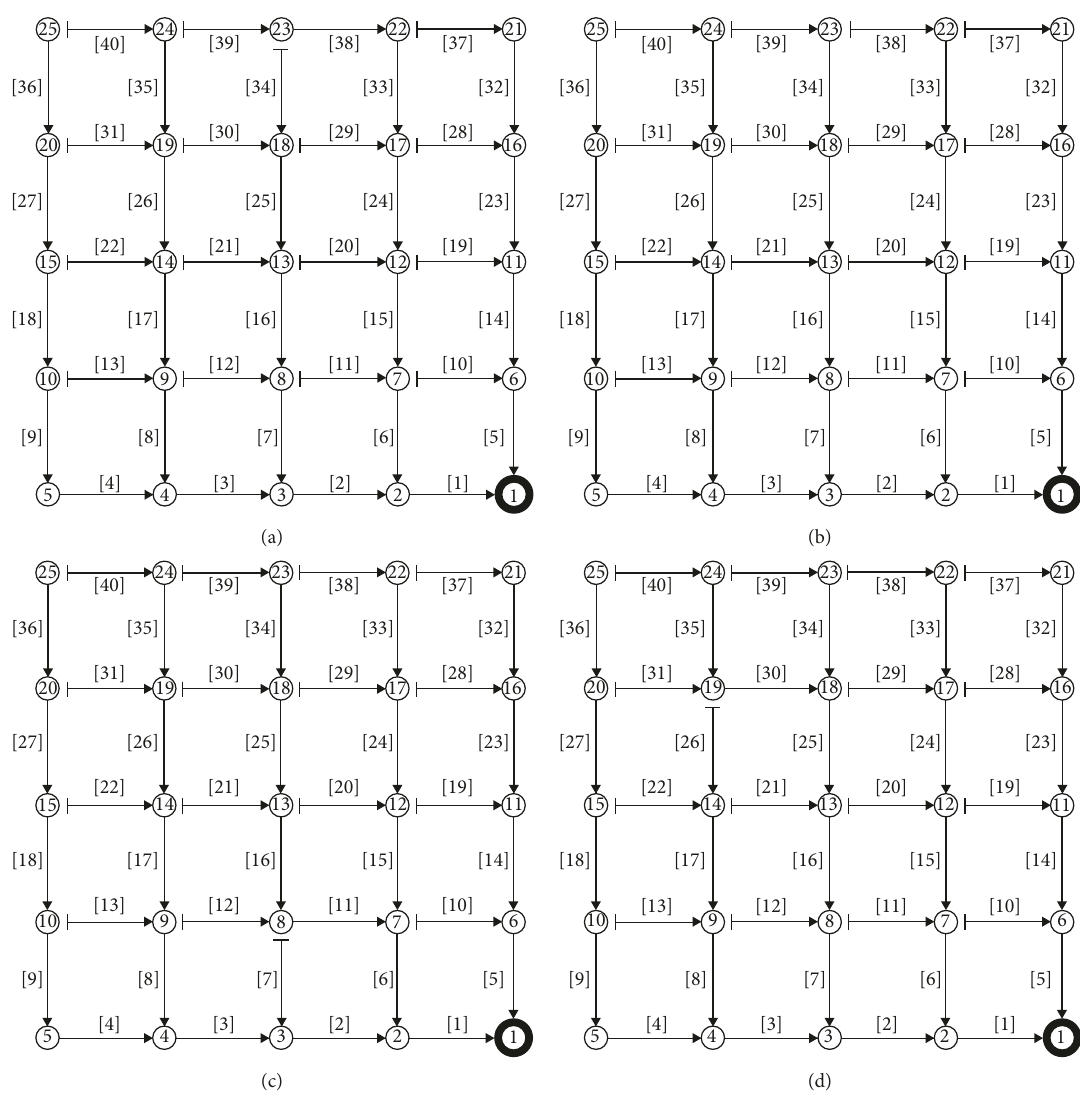
Figure 12: The four different consequence